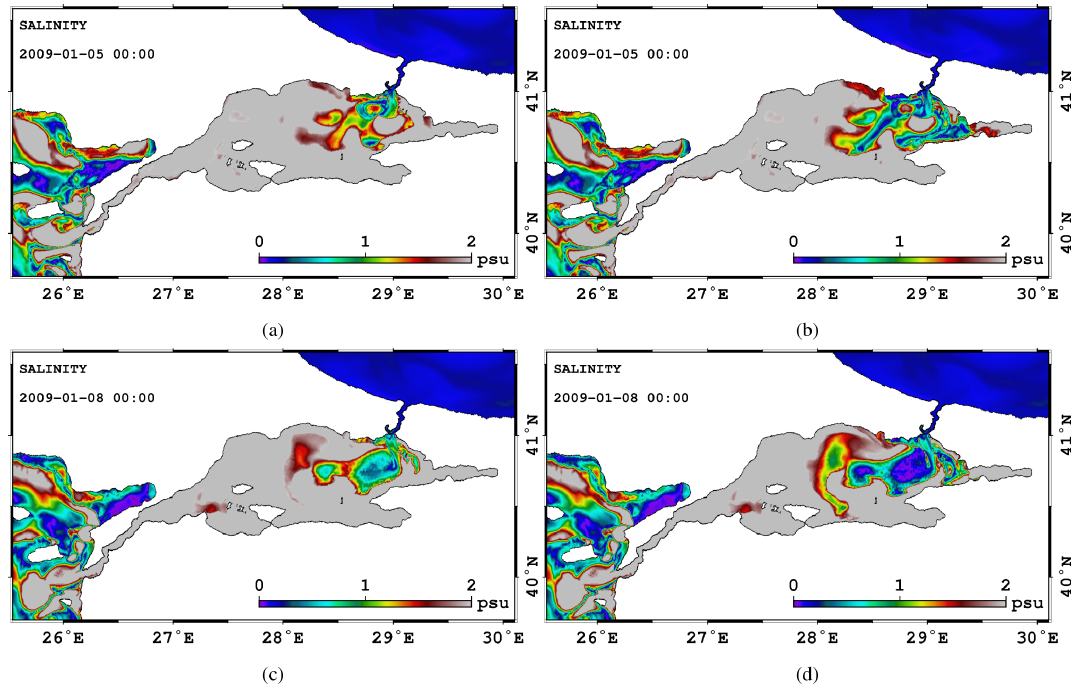
Figure 11. RMS of the difference between NR and prior ensemble mean salinity at the first 10m. Comparison of FB001 (a, c) and FB002 (b, d) is shown for 5 January 2009 (a, b) and 8 January 2009 (c, d) . RMS of difference is higher than 2psu in the gray areas.